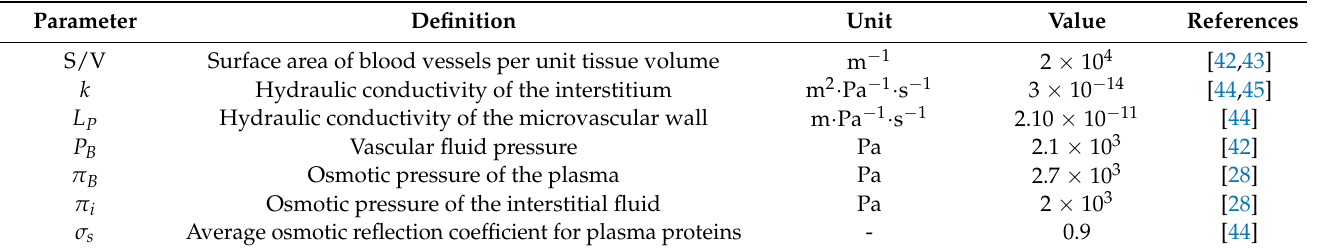
Table 1. Parameters for tumor tissue.